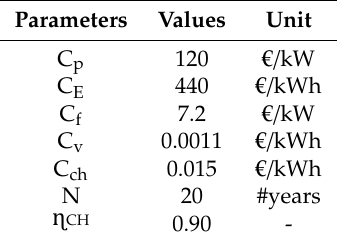
Table 8. Economic inputs.